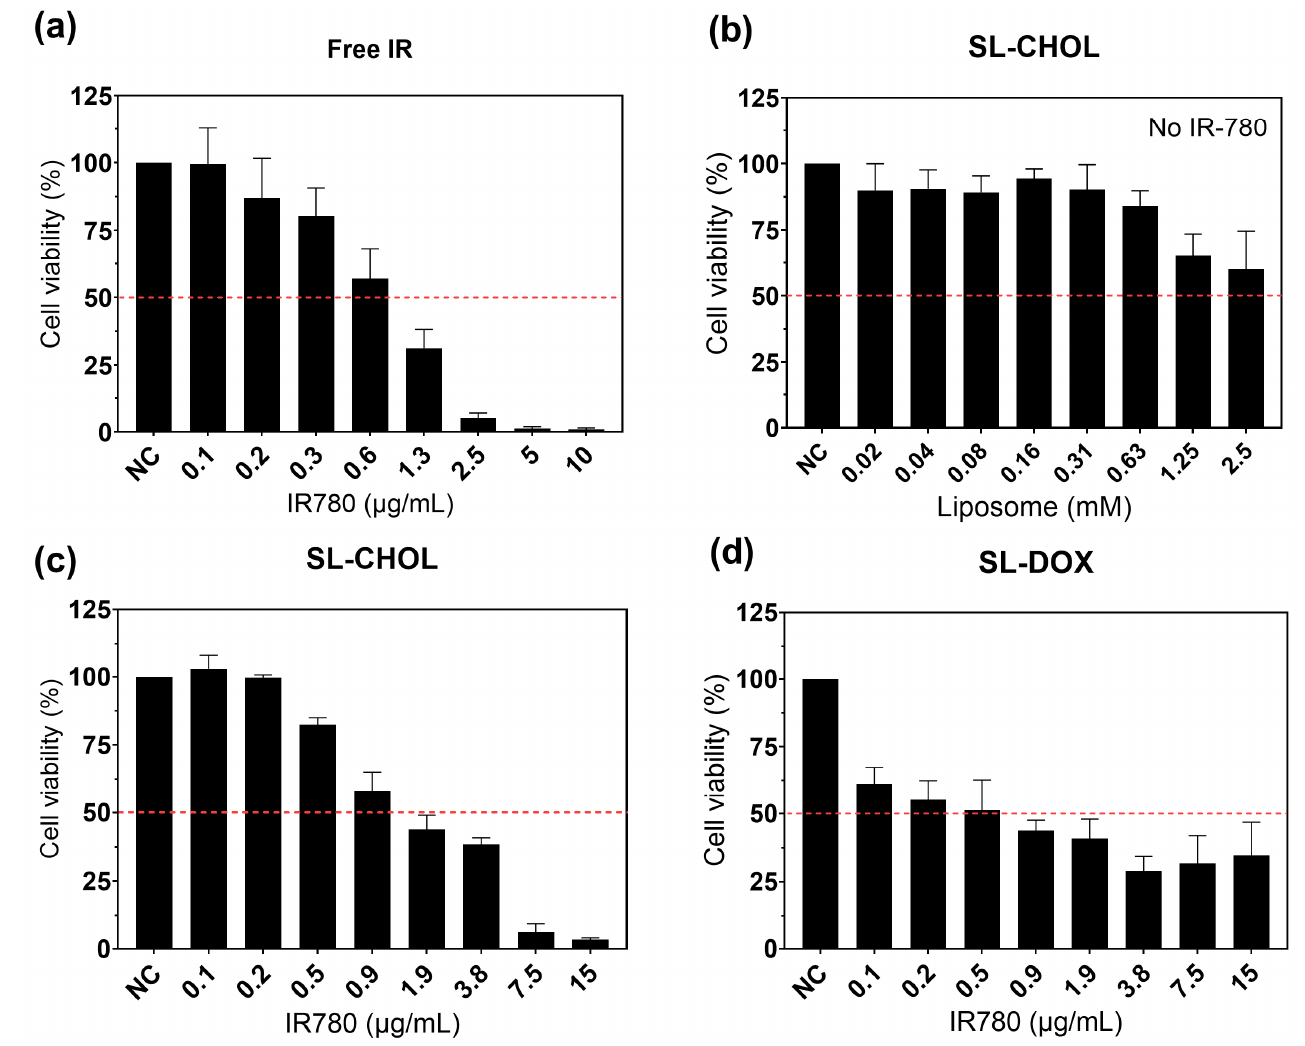
Figure 6. Cell viability study without laser irradiation: ( a ) MTT study as a function of free IR-780 concentration; ( b ) MTT investigation of the toxicity of SL-CHOL without IR-780; ( c ) MTT study of SL-CHOL containing IR-780; ( d ) MTT study of SL-DOX. DOX encapsulated in the vesicles decreases the IC50. The variation in concentration (IR-780) arises from the dilution of the original sample.